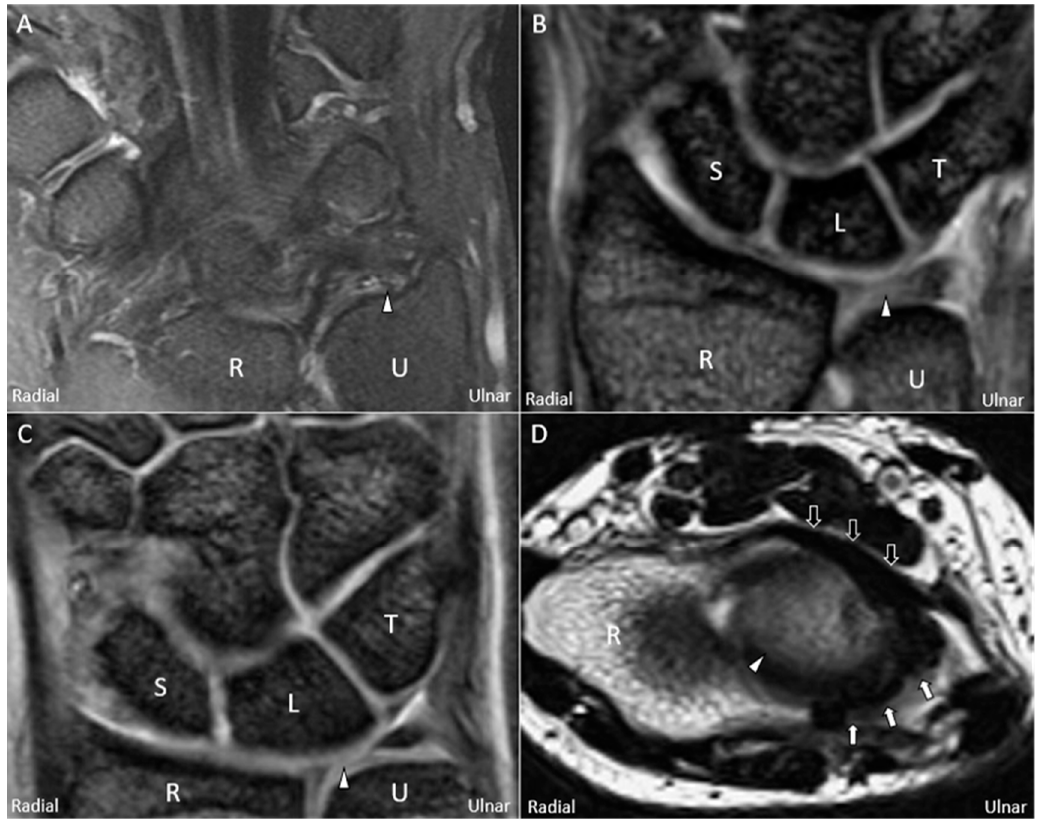
Figure 2. Magnetic resonance imaging (coronal T2-weighted view) showing ( A ) avulsion of the articular disc (white arrowhead) from the ulnar fovea, ( B ) central tear of the disc, and ( C ) radial avulsion of the articular disc. ( D ) Magnetic resonance imaging (axial T2-weighted view) showing a swollen palmar radioulnar ligament (black arrow) and a torn dorsal radioulnar ligament (white arrow) surrounding the articular disc. U: ulna; R: radius; L: lunate; T: triquetrum; S: scaphoid.